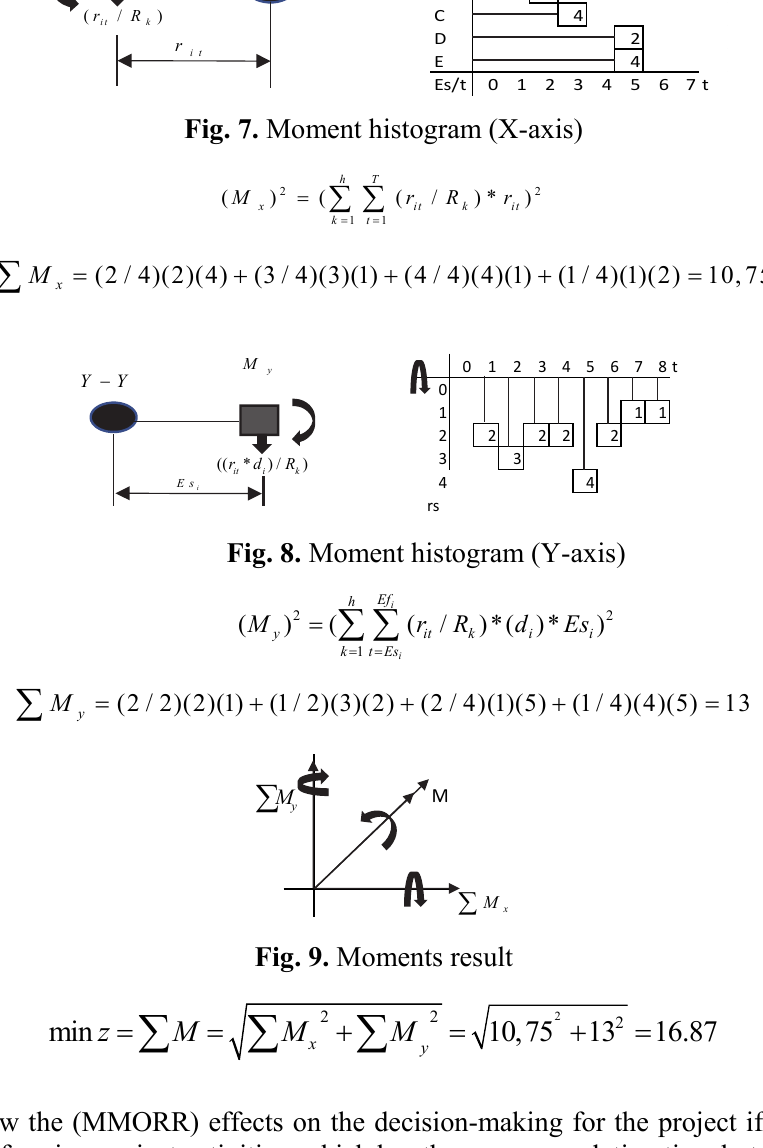
Fig. 7. Moment histogram (X-axis)